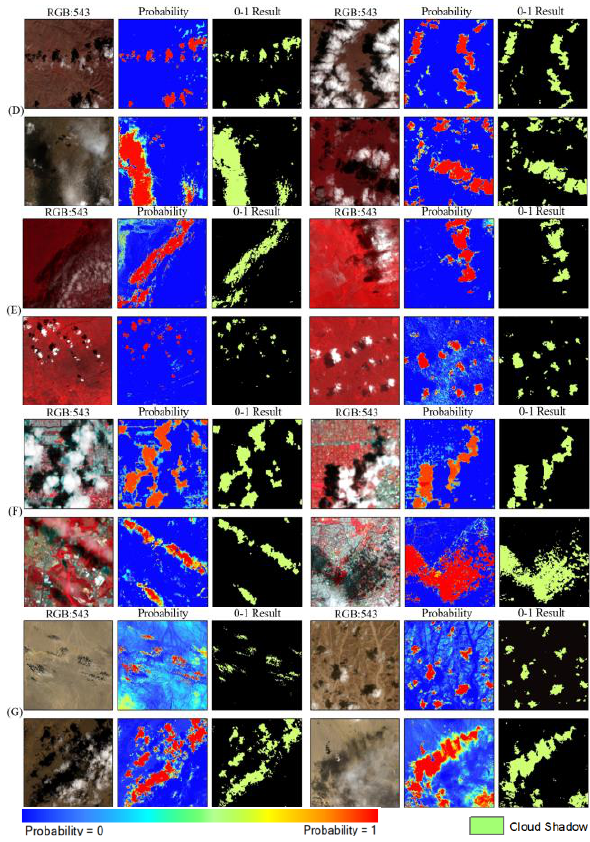
Figure 3. Cloud shadow detection results (P>0.75) (A) ： cultivated land (B) ： forest (C) ： grassland (D) ： shrubland (E) ： wetland (F) ： artificial surface (G) ：